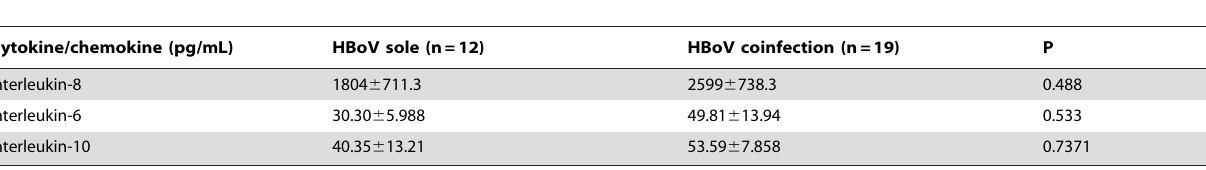
Table 7. Cytokine/chemokine concentrations of respiratory tract aspirates in children who had HBoV detection with or without detection of other viruses.